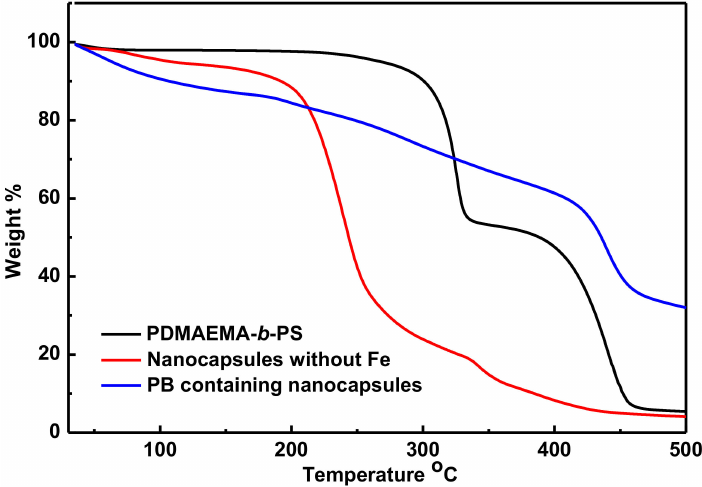
Figure 5. TGA traces of PDMAEMA-b-PS, nanocapsules without Fe and PB containing